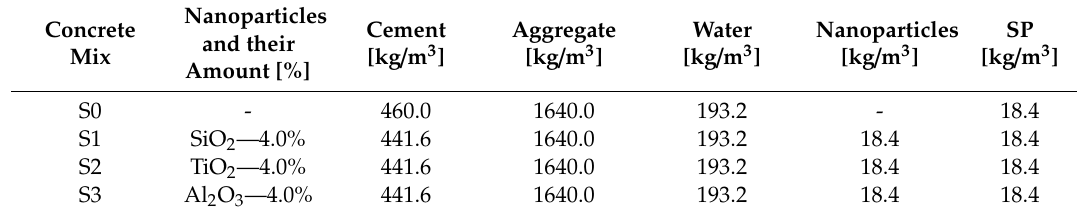
Table 2. Composition of the designed mixes.